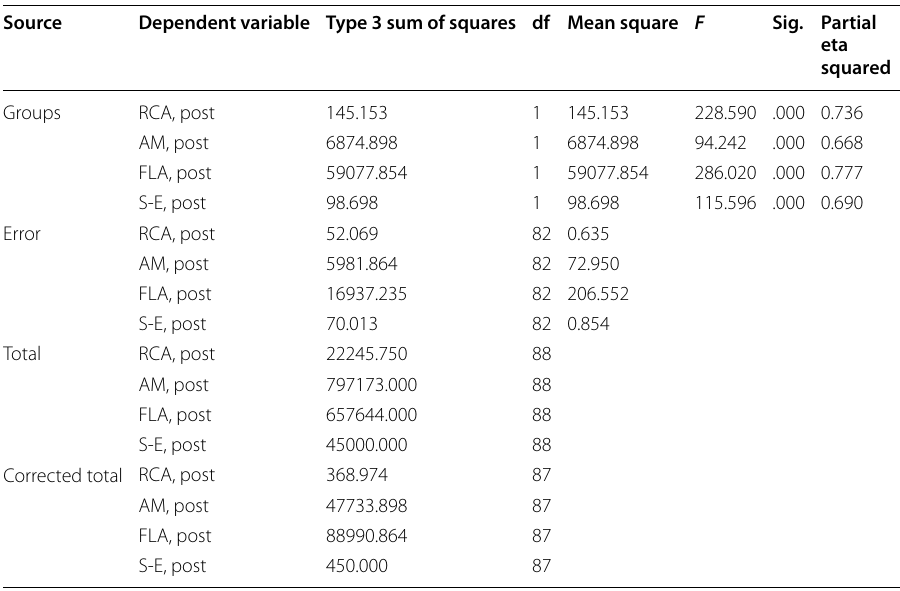
Table 5 Results of tests of between-subject effects for RCA posttest, AM posttest, FLA posttest, and SS-E posttest